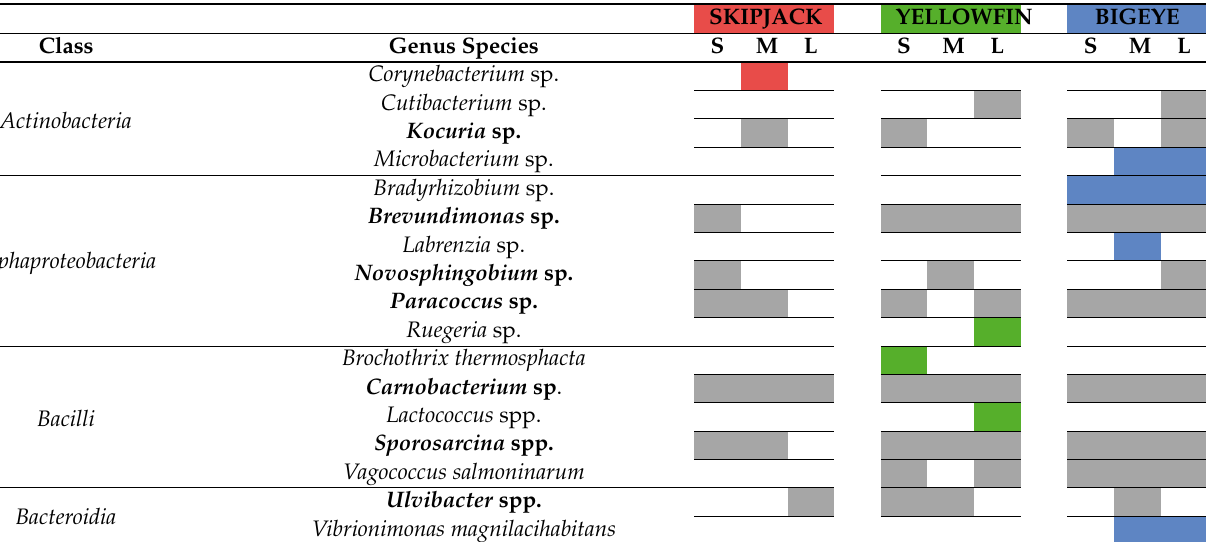
Table 3. Bacterial genera representative of the ‘Core Microbiota’ (determined with the microbiome package in R) in the gut of Skipjack, Yellowfin and Bigeye tunas, in the small (S), medium (M) and large (L) size categories. Taxa common to all the three tuna species are represented by grey squares. Red, green and blue squares correspond to unique taxa present in each